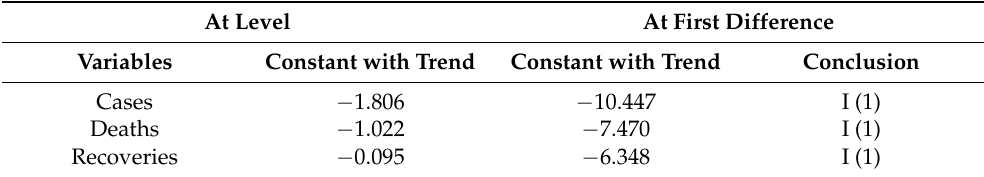
Figure 3. Differenced series: 1st order difference for confirmed cases ( top left ), death counts ( top right ), and recovered cases ( bottom center ). Table 1. Augmented Dickey-Fuller test